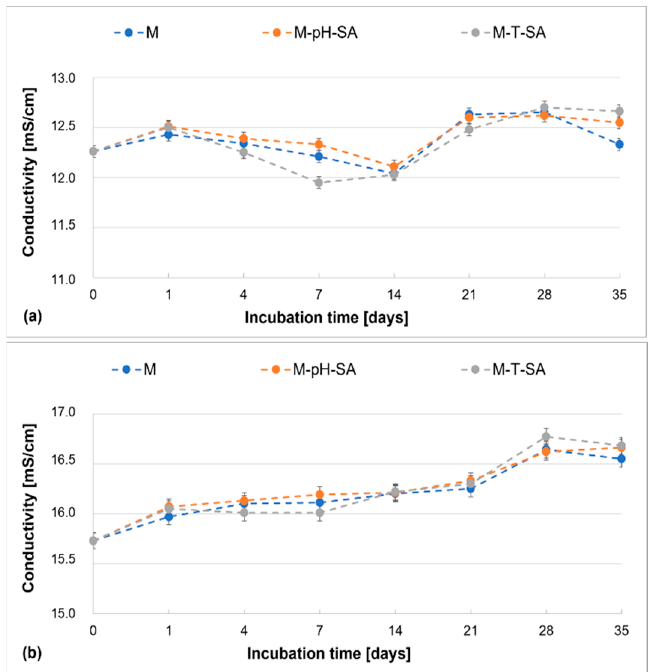
Figure 3. Changes in conductivity of the basic matrix (M), the system with a pH-sensitive nanocarrier and salicylic acid (M-pH-SA), and system with a thermosensitive nanocarrier and salicylic acid (M-T-SA) at 37 °C during 35-day tests in ( a ) PBS and ( b ) SBF ( n = 3).